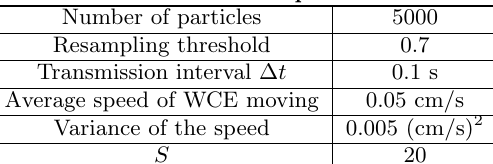
Table 1: Simulation parameters.